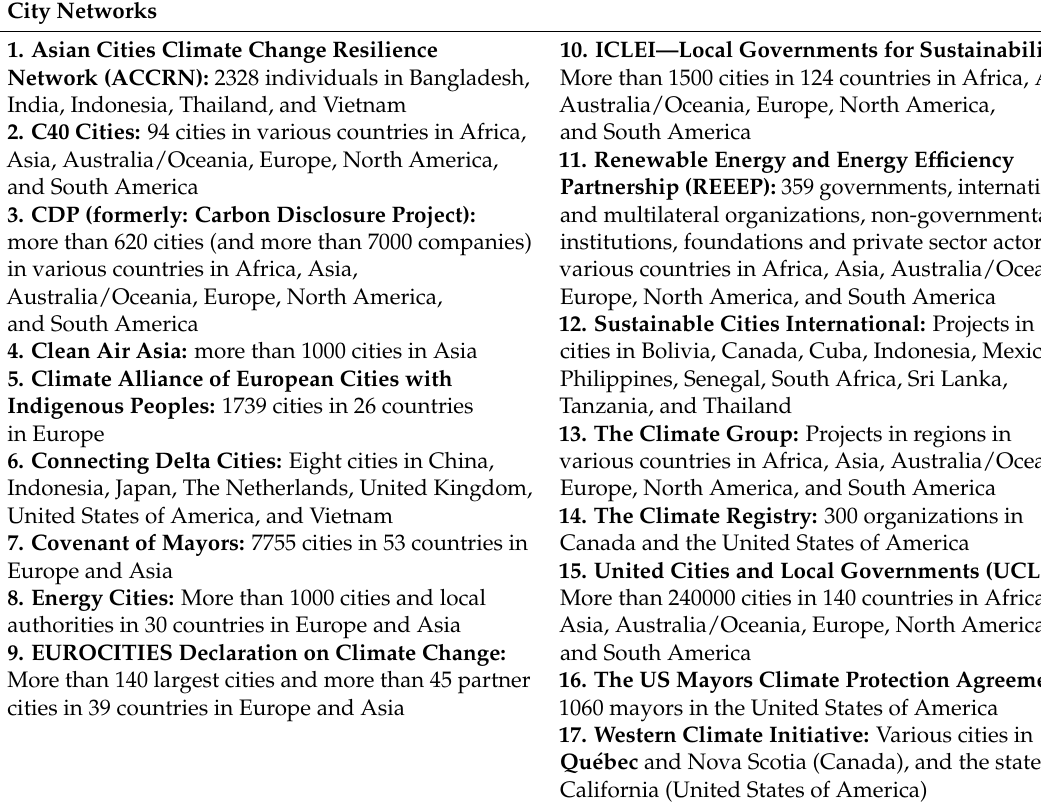
Table 1. Transnational city networks included in the